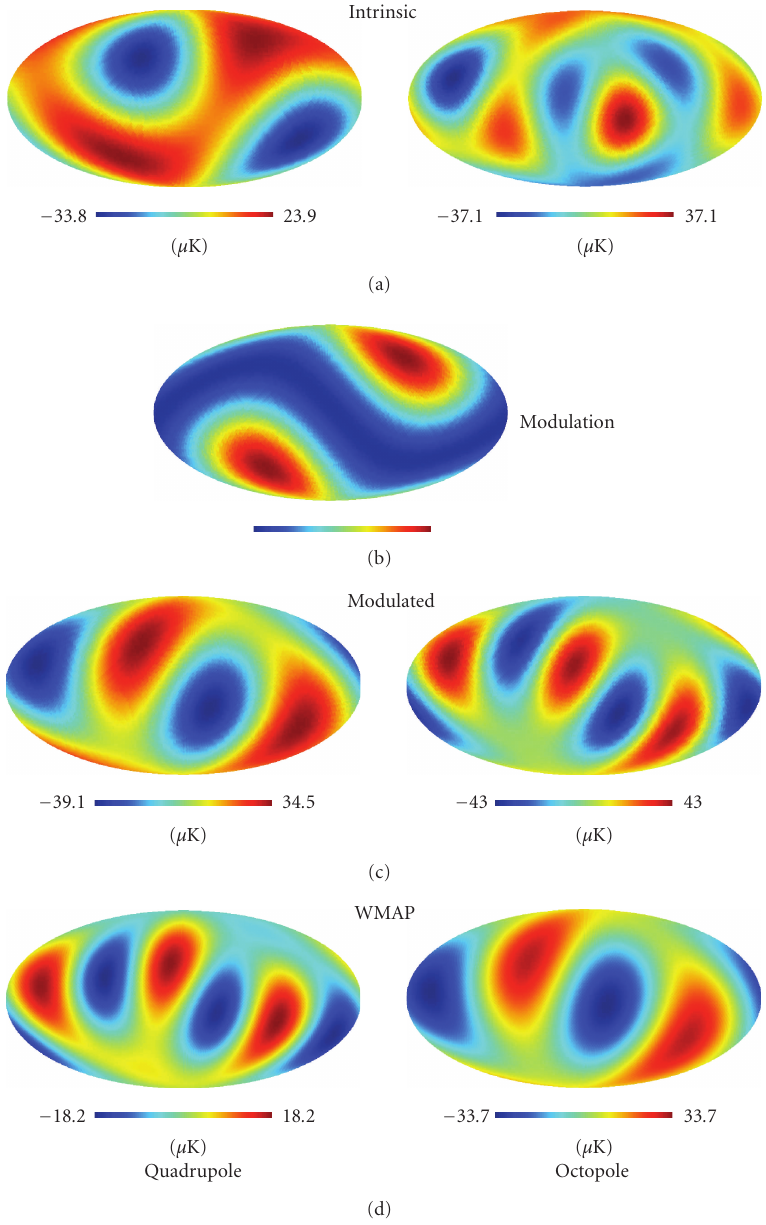
Figure 7: A realization of the multiplicative model where the quadrupole (left column) and octopole (right column) exhibit an alignment similar to WMAP. (a): intrinsic (unmodulated) sky from a Gaussian random isotropic realization. (b) (single column): the quadrupolar modulation with f = − 1 and w 2 = − 7 (see (21)) in the dipole direction. (c): the modulated sky of the observed CMB. (d): WMAP full-sky quadrupole and octopole. Adopted from